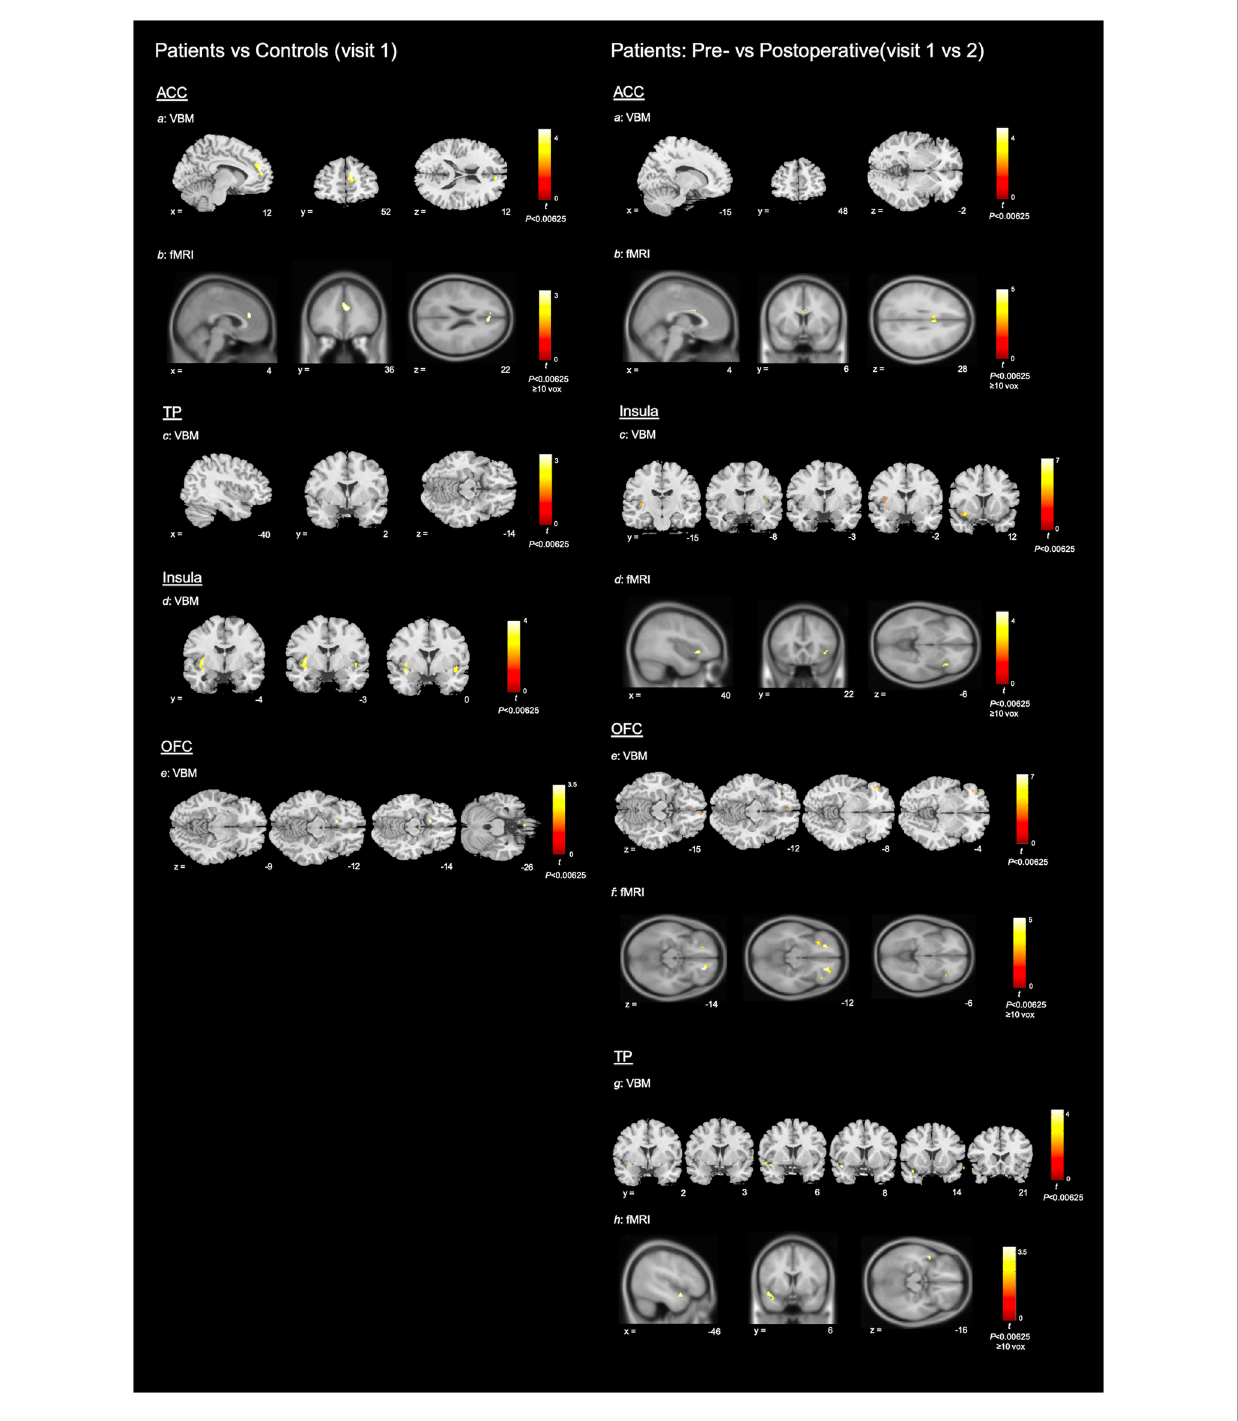
FIGURE 5 Neuroimaging results. To help differentiate between imaging modalities, VBM results are shown using the ch2bet stripped skull brain template and fMRI results are shown using the avg152T1 brain template. All coordinates are in MNI space. Colour bars show associated peak T score (please note that the maximum integer labelled may not reach top of colour bar range). Left : patients vs. controls (visit 1): Structural and functional MRI results for patients (visit 1) vs. controls. For ease of display — axial sections only shown for OFC results and coronal sections only shown for results within the insula. Subsections: ( a ) VBM results for increased GM volume within the ACCof patients compared with controls ( P <0.00625); ( b ) fMRI results for increased BOLD signal with the ACC of controls compared with patients ( P <0.00625, ≥ 10 voxels); ( c – e ) VBM results for increased GM volume in patients compared with controls, within the TP, insula and OFC ( P <0.00625). Right : Patients pre- vs. postoperative (visit 1 vs. 2): Structural and functional MRI results for decrease in GM volume and increase in BOLD signal after surgery, in the patient group. For ease of display — axial sections only shown for OFC results and coronal sections only shown for VBM results within the insula and TP. Subsections: ( a ) VBM results for decreased GM volume within the ACC of patients after surgery ( P < 0.00625); ( b ) fMRI results for increased BOLD signal within the ACC of patients after surgery ( P <0.00625, ≥ 10 voxels); ( c – h ) VBM results for decreased GM volume and fMRI results for increased BOLD signal within the insula, OFC and TP of patients after